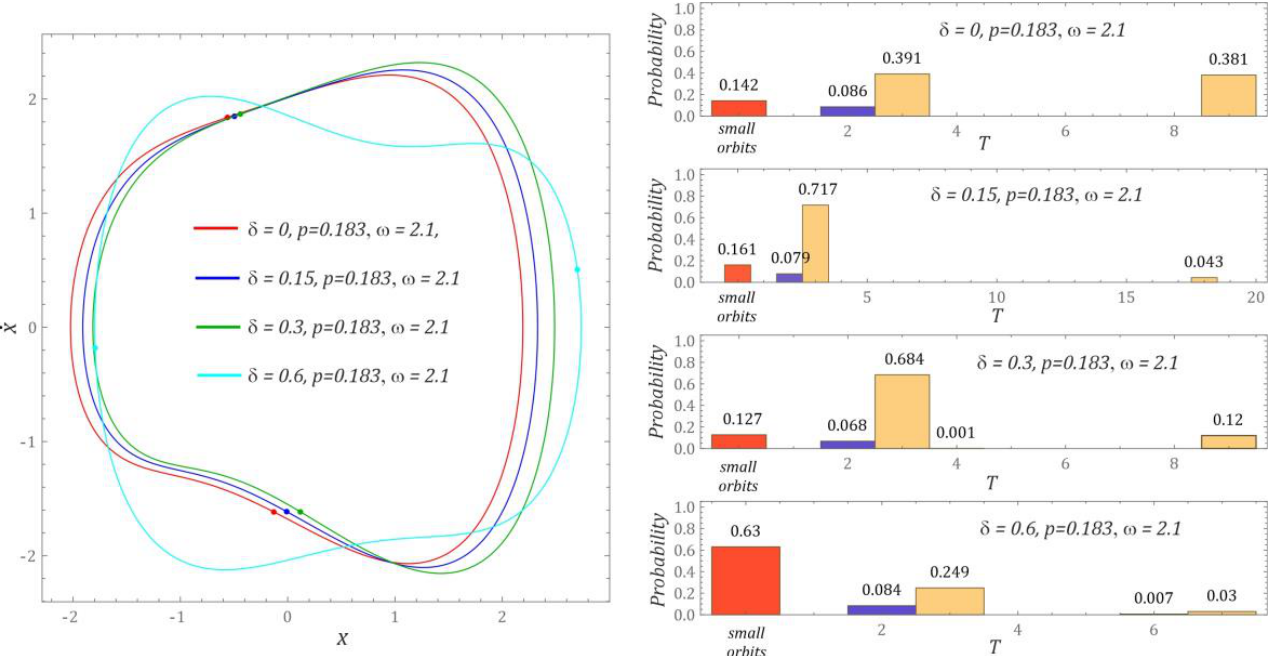
Figure 7. Numerical results showing the influence of potential asymmetry on the probability of occurrence of particular solutions for different values of δ ( δ = 0.0, 0.15, 0.30, and 0.60, respectively). The horizontal axis T is related to the excitation period, and it is the unit of the response periodicity in the response probability diagrams. The colors represent the different orbits of δ parameter.